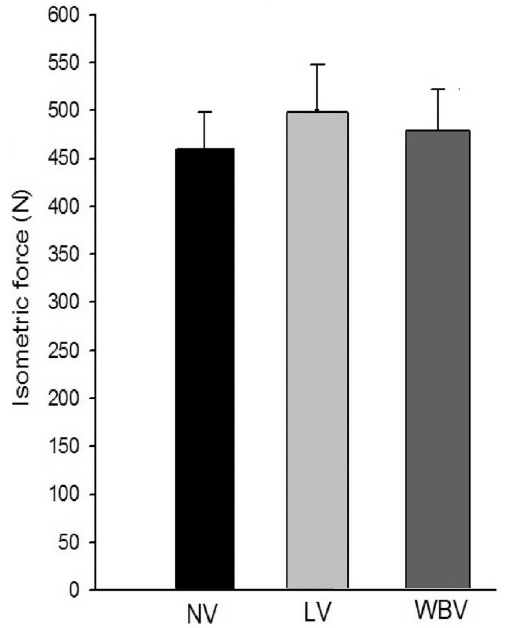
Figure 6 - Comparison of maximum isometric voluntary contraction. NV = No vibration; LV = Local Vibration; WBV = whole body vibration. Vertical lines = standard